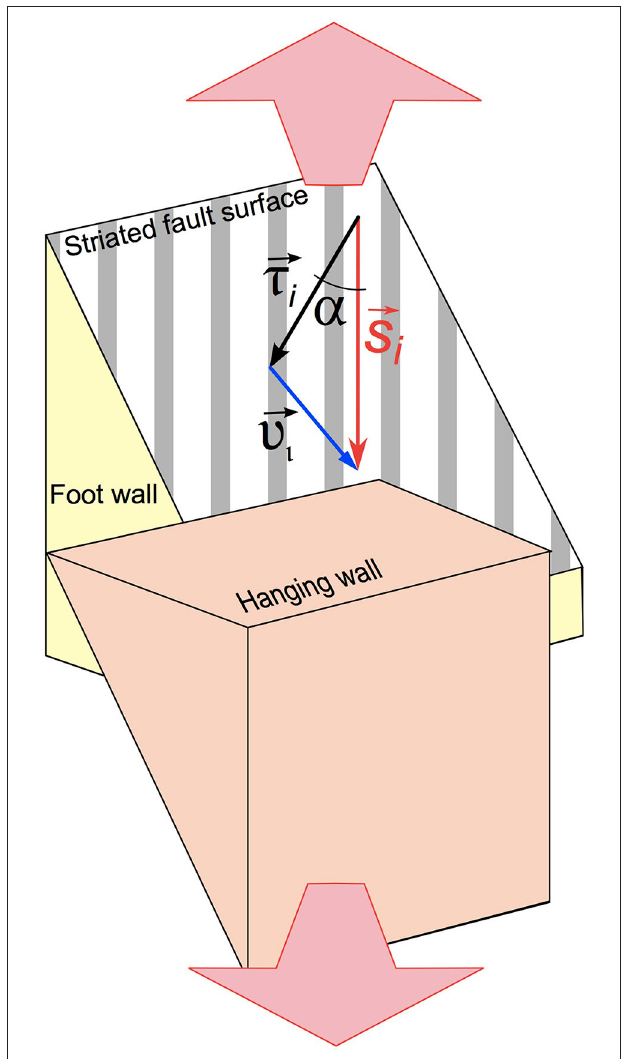
FIGURE 2 | Misfit criteria adopted in stress inversion procedures. α angle formed between the actual slip vector (s i ) and the theoretical shear stress ( τ i ) acting on each fault of the analyzed dataset (Carey and Brunier, 1974; Angelier, 1990 ); υ i , the vector difference between s i and τ i (Angelier, 1990).